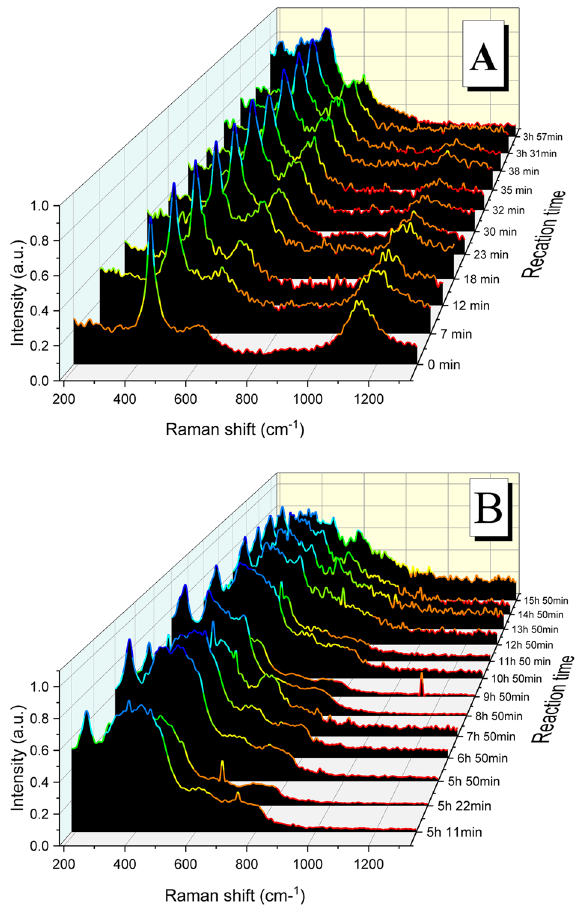
Figure 5. Raman spectra acquired during the experiment at 300 °C and 21%O 2 showing the formation of different oxidized phases: ( A ) UO 2+x and U 3 O 7 during the first 5 h and ( B ) U 3 O 8 from 5 h